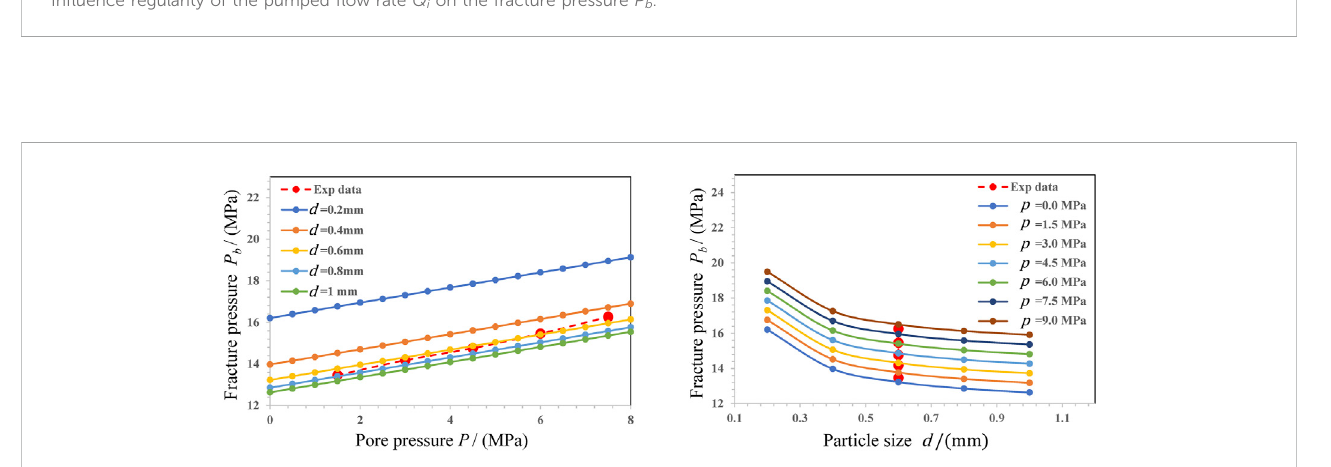
FIGURE 11 In fl uence regularity of the particle size d on the fracture pressure P b